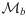
Global RoCoF disturbance magnitude Mb vs. the artificially varied system inertia Msys in the European grid.Each point corresponds to the loss of a single power station, with colors related to the squared component u2b2 of the Fiedler mode on the power loss bus. Color code and label symbols are the same as in Fig 8. The arrow indicates the data point corresponding to the top left data point, also indicated by an arrow in Fig 11.